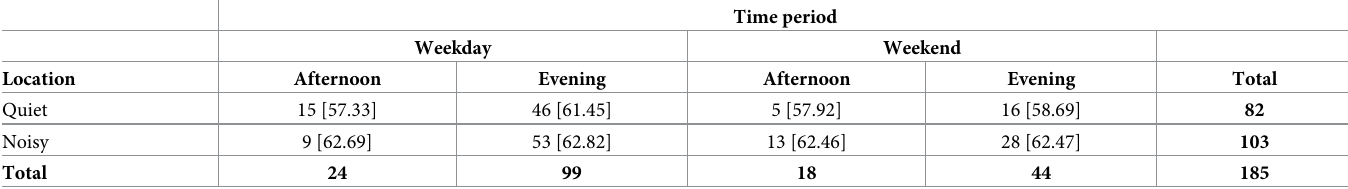
Table 1. Case counts [and sound levels in dBA (LA eq,10min )] for each condition of in-situ data collection, separated by weekday-weekend, afternoon-evening, and noisy-quiet side of the space.